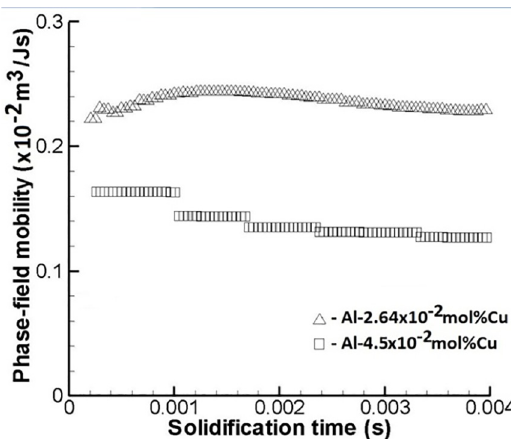
Figure 5: Phase-field mobility versus solidification time for the Al-2.64×10 –2 mol%Cu and Al-4.5×10 –2 mol%Cu alloys.